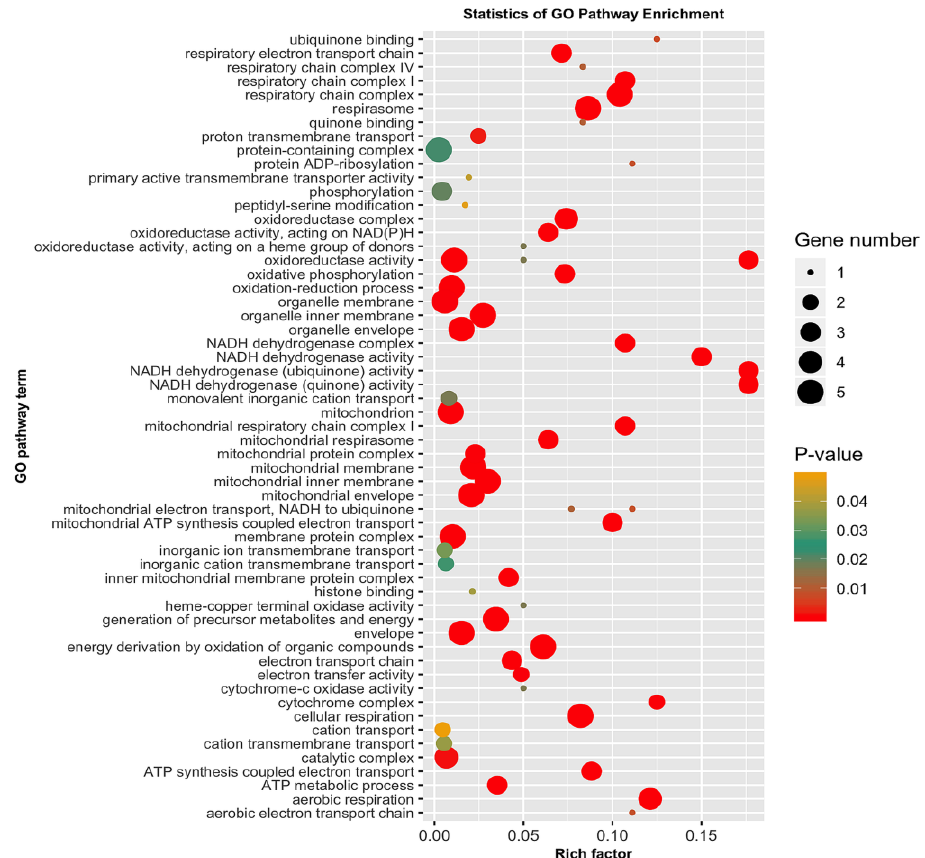
Figure 6. Gene ontology (GO) pathway enrichment analysis for the 50 genes encoded by the putatively adaptive SNP loci in P. monodon population.